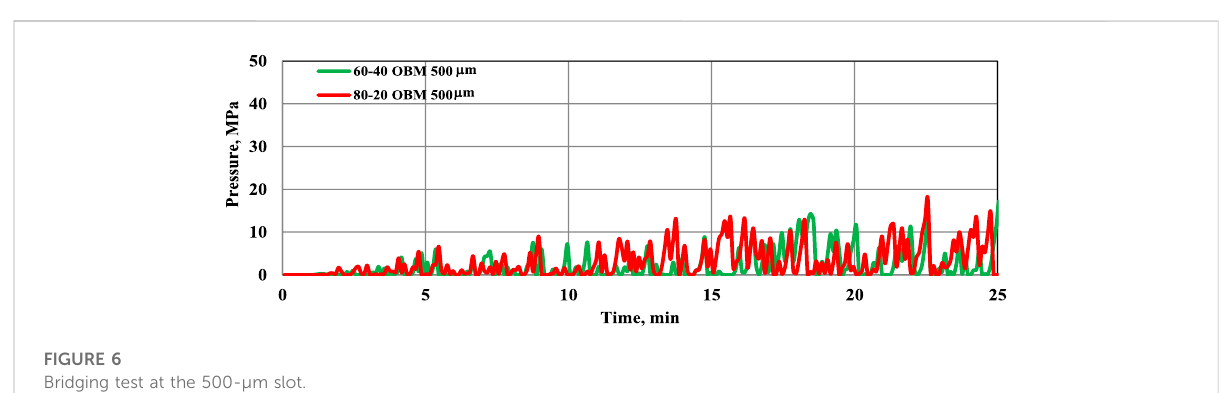
FIGURE 6 Bridging test at the 500- μ m